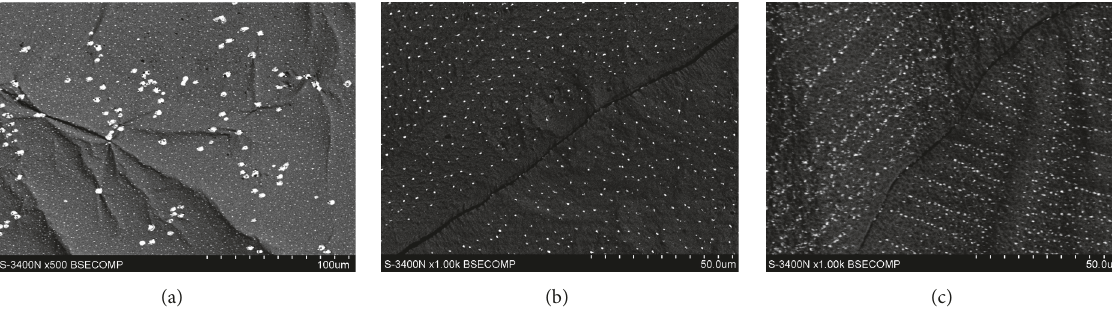
Figure 4: SEM micrographs of air-cooled sample surfaces: (a) Pb 1.2, (b) Pb 0.8, and (c) Pb